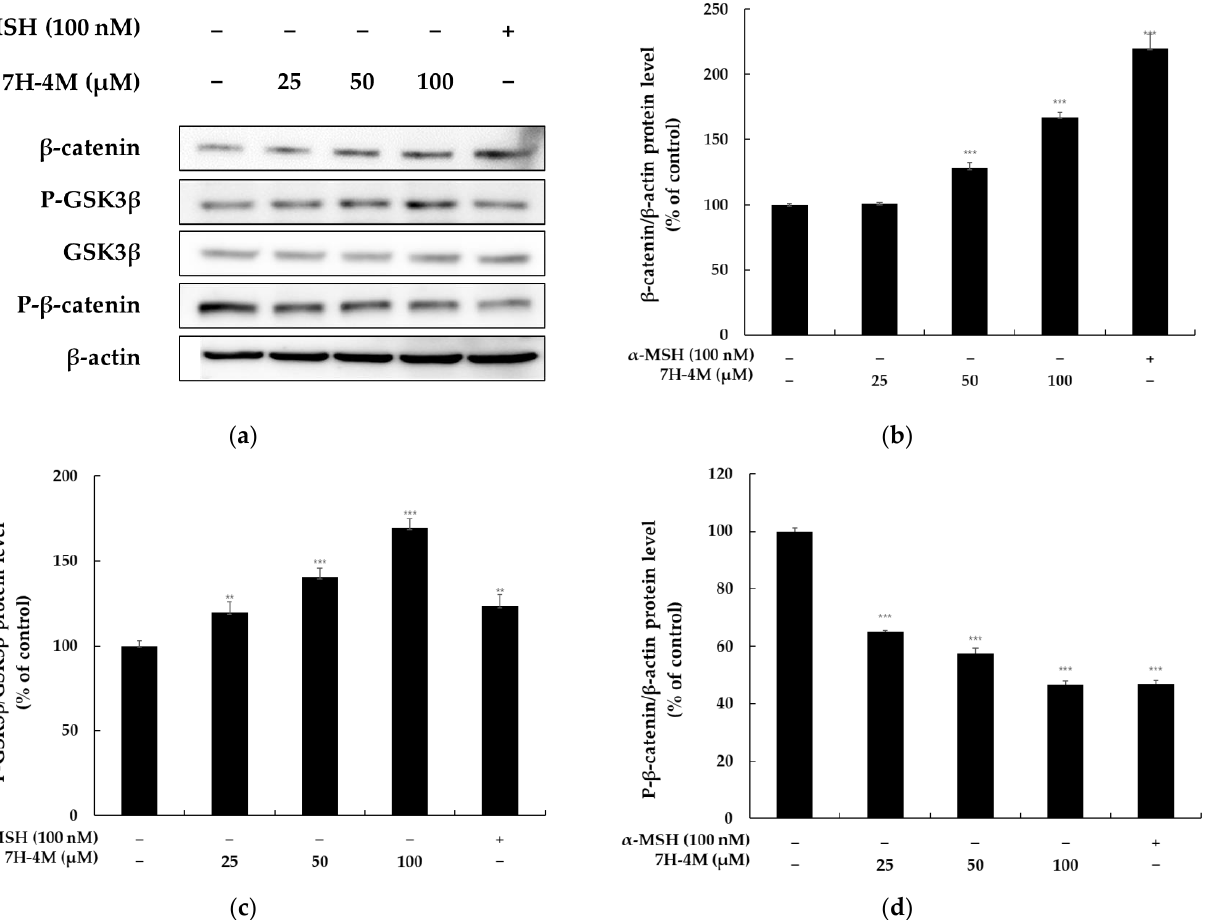
Figure 5. The effect of 7H-4M on the melanogenesis-related protein expression of B16-F10 cells. The experimental protocol involved treating B16-F10 cells with 7H-4M at varying concentrations for 24 h. The cells were then collected and protein extracts were prepared from each group. The expression levels of P- GSK3β, P - β - catenin, and β -catenin were assessed through Western blot analysis. The relative intensity of the protein bands was measured using ImageJ software, and the values were normalized to the corresponding loading control. The untreated cells were considered as having 100% expression. ( a ) Western blotting results and ( b ) β -catenin, ( c ) P-GSK3, and ( d ) P- β -catenin